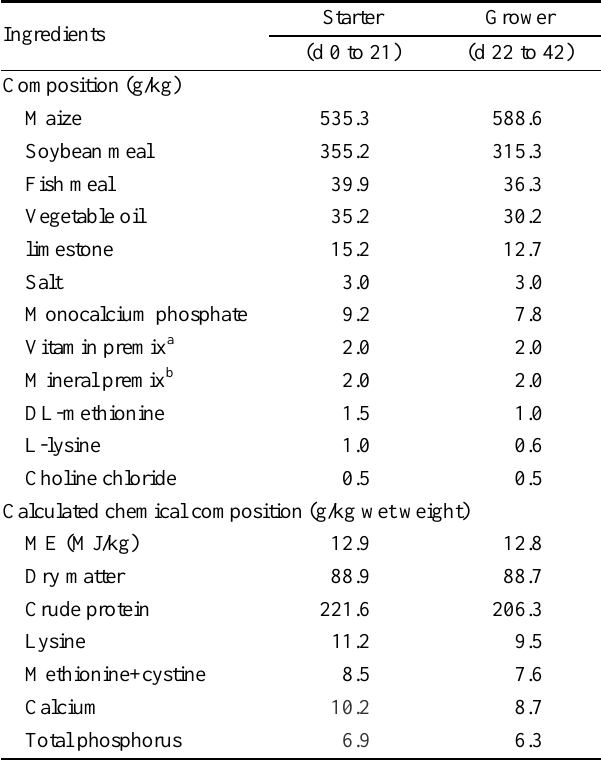
Table 1. Composition of the basal